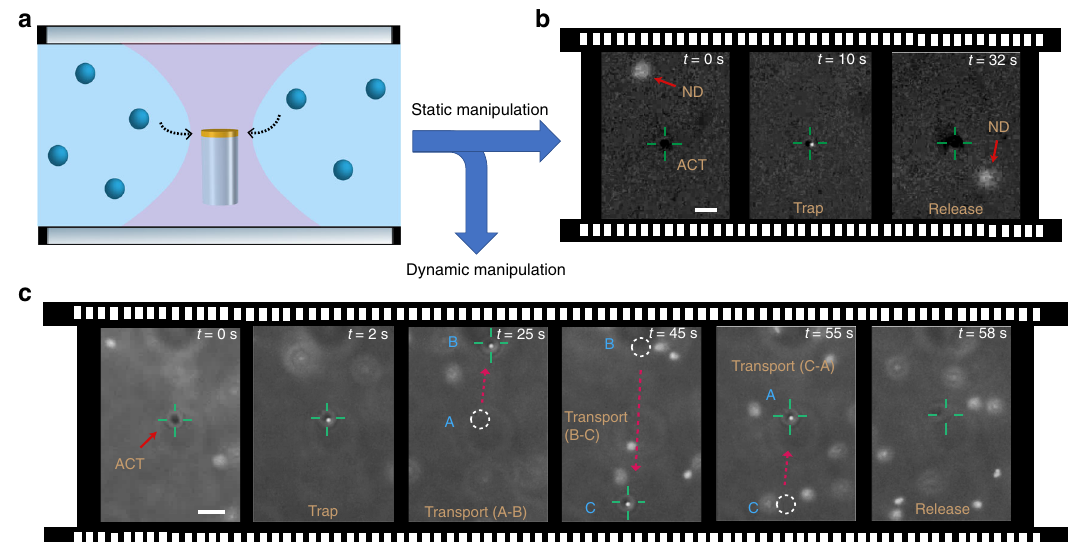
Fig. 3 Demonstration of static and dynamic manipulation by ACTs. a Schematic of an ACT held in liquid with a focused laser beam. b Trapping of 100 nm fl uorescent nanodiamonds with illumination intensity 4 mW μ m − 2 and its subsequent release by turning off the illumination. c Trapping, transport and release of 200 nm fl uorescent polystyrene bead in PBS buffer. All scale bars correspond to 3 μ